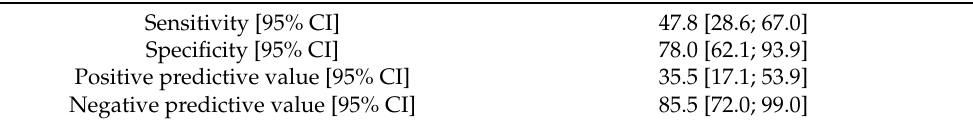
Table 3. Characteristics of the Odysight ® test for exudative recurrence screening if patients used the application at least one time per week ( n =